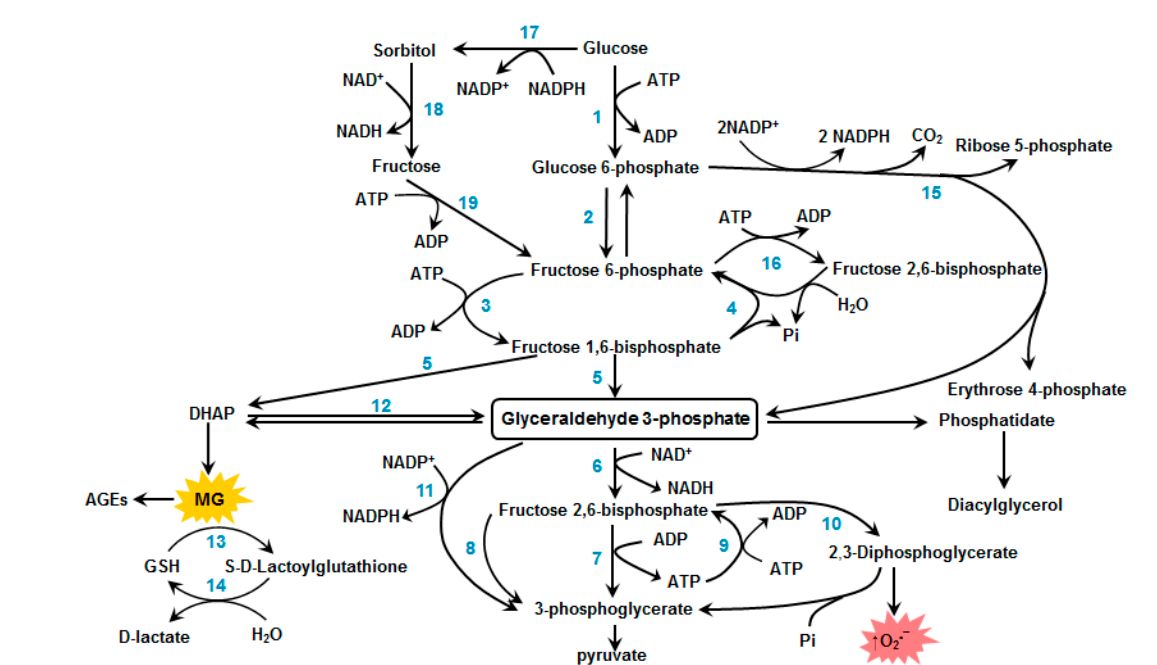
Figure 2. Futile cycles and shunts of glycolytic pathway in red blood cells. Enzymes catalyzing these reaction are designated by numbers: 1—hexokinase, 2—glucose phosphate isomerase, 3—phosphofructokinase, 4—fructose 1,6-bisphosphatase, 5—fructose diphosphate aldolase, 6—glyceraldehyde phosphate dehydrogenase (GAPDH), 7—phosphoglycerate kinase, 8—oxidized GAPD (GAPD-SOH), 9—phosphoglycerate kinase, 10—bisphosphoglycerate mutase, 11—non-phosphorylating glyceraldehyde phosphate dehydrogenase (GAPDH), 12—triose phosphate isomerase, 13—glyoxalase i, 14—glyoxalase ii, 15—glucose 6-phosphate dehydrogenase, 16—fructose 2,6-bisphosphatase, 17—aldose reductase, 18—sorbitol dehydrogenase, 19—hexokinase.